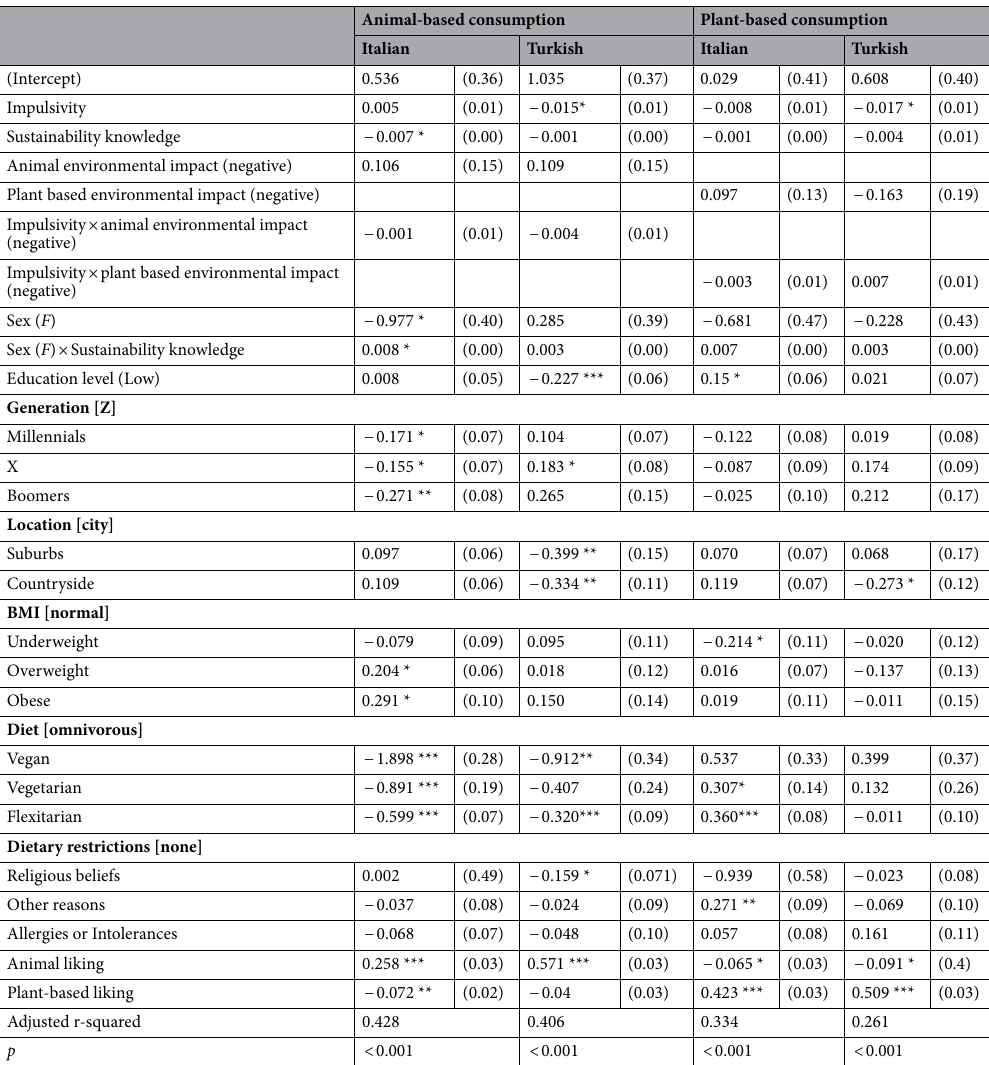
Table 2. Coefficients, standard errors (SE) and p values for the Italian and Turkish regression models for animal-based food consumption and for plant-based food consumption. The models are adjusted for sociodemographic characteristics, BMI, eating behaviors and the interaction between sustainability knowledge and sex. Standard errors are in parenthesis. Reference categories are in square brackets. Signif. codes: 0.001‘***’, 0.01‘**’,